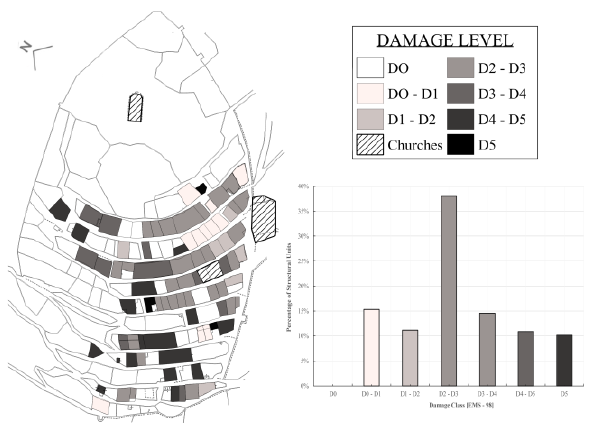
Figure 7. Damages distribution in Campi Alto di Norcia according to the EMS98 in a GIS environment.